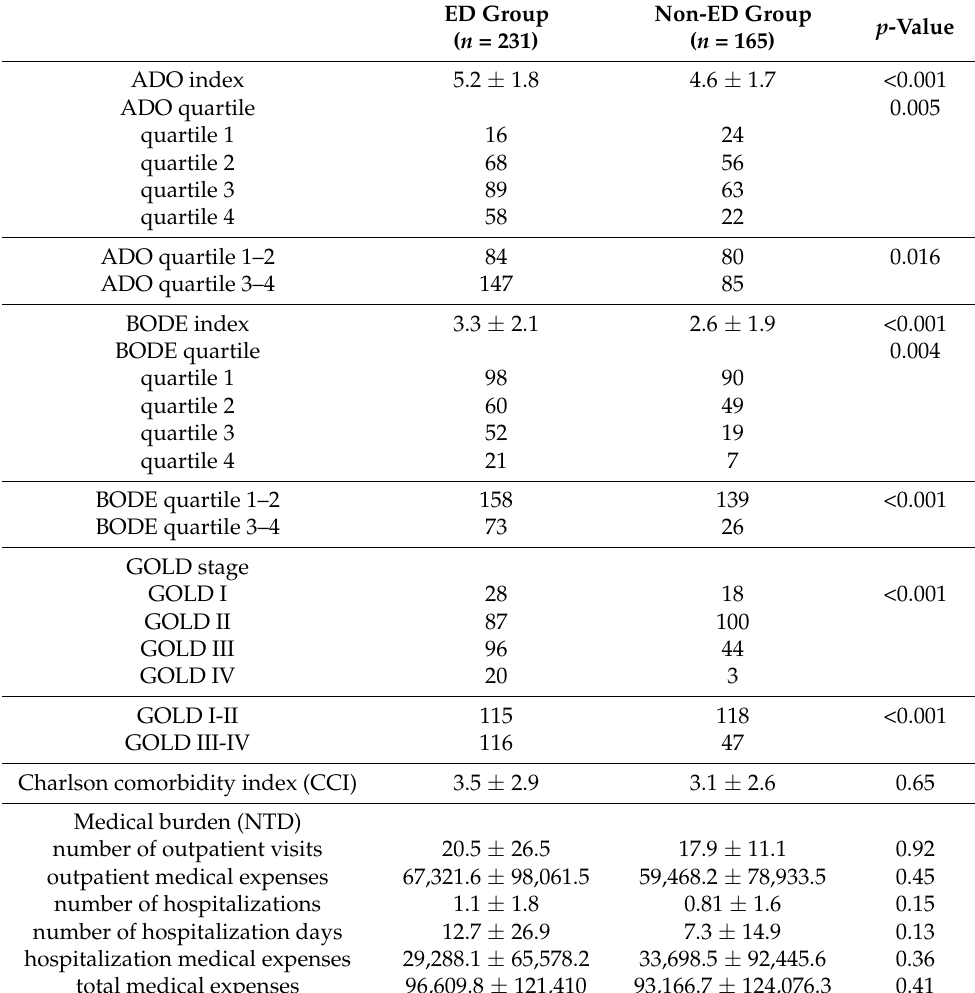
Table 3. Medical Burden and Index of the ED and Non-ED